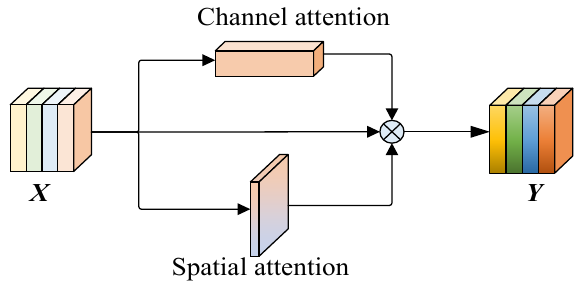
Figure 5. Hybrid domain attention structure for parallel combinations.